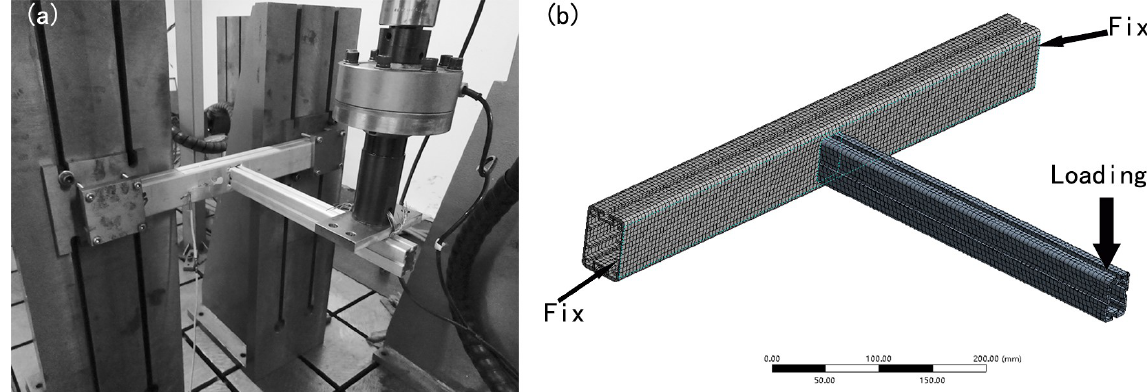
Figure 10: (a) Experimental schematic diagram; (b) simulation loading schematic diagram